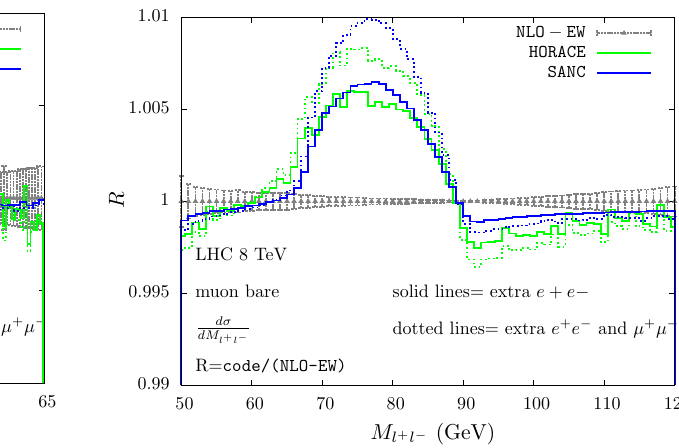
of emitting a e + e − and a μ + μ − pair. The HORACE results are shown in green and the SANC results in blue . The lepton transverse momentum ( left ) and the lepton-pair invariant mass ( right ) distributions are shown for the 8 TeV LHC with ATLAS/CMS